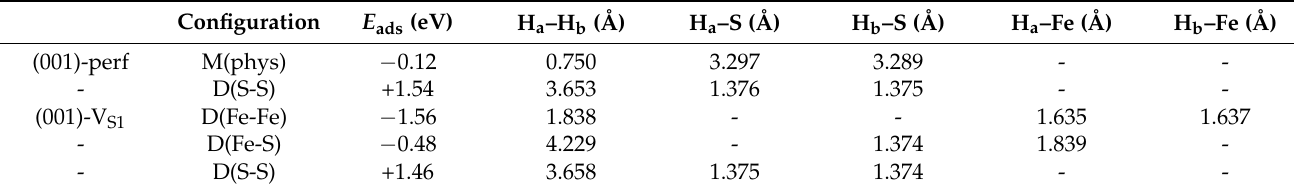
The reduction of CO 2 is one route for its removal and sequestration or utilization, as the reduced species may prove to be a valuable feedstock for other processes. Generally, CO 2 reduction may occur through the reverse water-gas shift reaction (CO 2 + H 2 → CO + H 2 O), a major side reaction in methanol synthesis. Therefore, we have analyzed the reactions between CO 2 and H adatoms and determined the reaction pathway on the defective V S2 FeS (001) surface. Different possible CO 2 and H 2 coadsorption structures were explored to determine the lowest-energy coadsorption structure (IS, Figure 7). In the coadsorption structure, the adsorption structures of CO 2 and H adatoms are identical to that of the isolated individual species. The coadsorption energy with respect to free CO 2 and H 2 was calculated at − 3.68 eV, which is more exothermic than the sum of the isolated adsorption energies of CO 2 and 2H ( − 3.34 eV). The increased stability of the coadsorbed system indicates an attractive interaction between the CO 2 and H adatoms on the defective FeS (001) surface. By allowing the H adatoms to react with the adsorbed CO 2 , we have calculated the reaction energies and activation barriers of the hydrogenation reactions of the activated CO 2 molecule on the defective FeS (001)